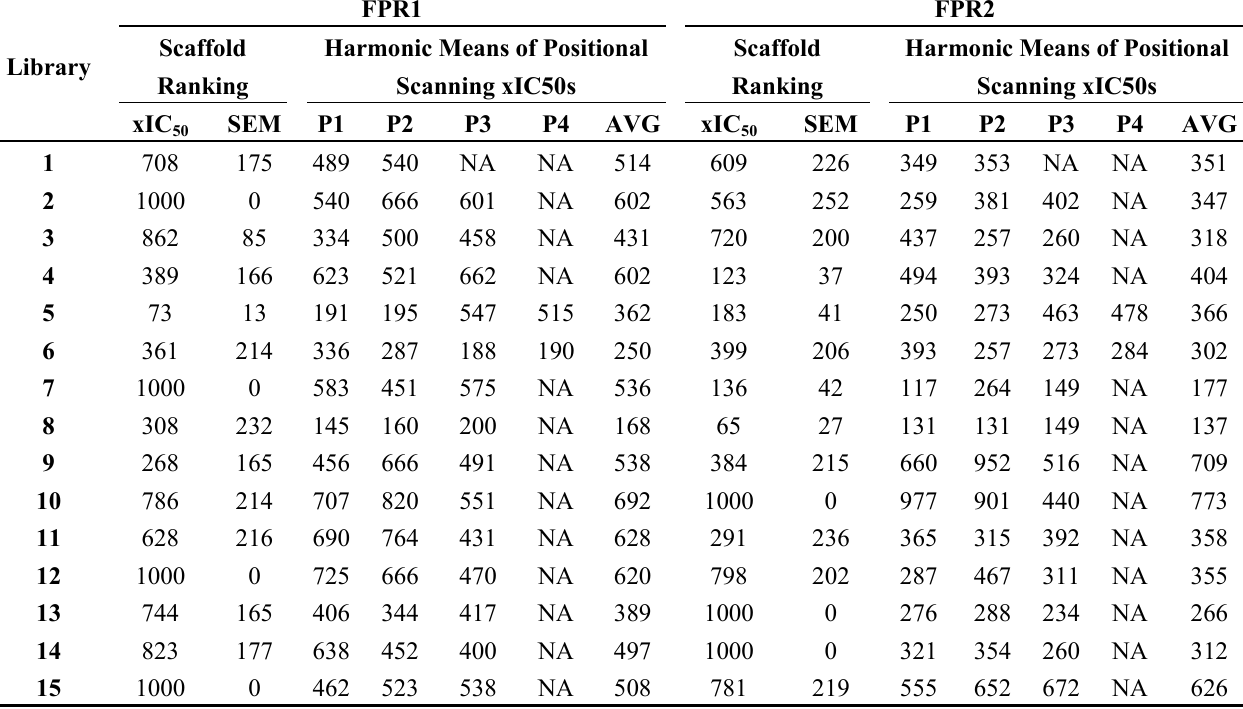
Table 1. Scaffold Ranking (cid:1876)(cid:1835)(cid:1829)50(cid:1871) , compared to the Harmonic Means of